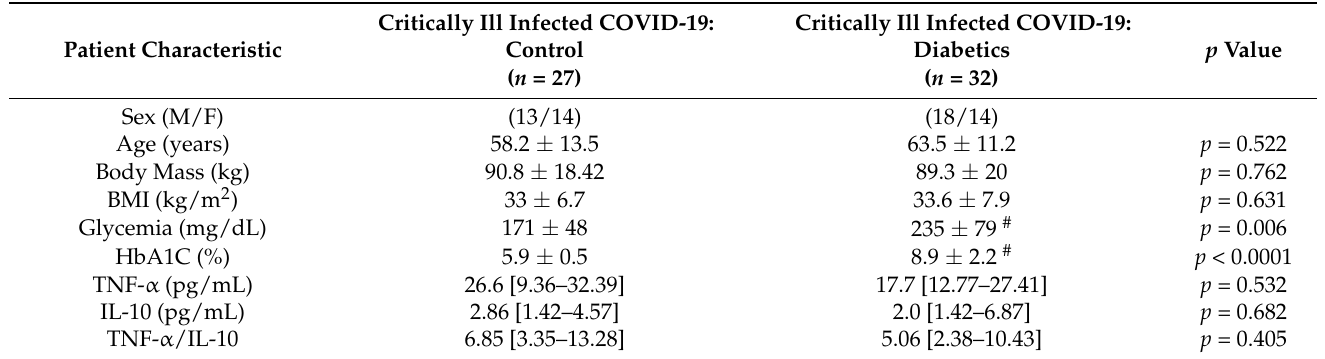
Table 1. Subjects’ characteristics, biochemistry, and cytokine profile.